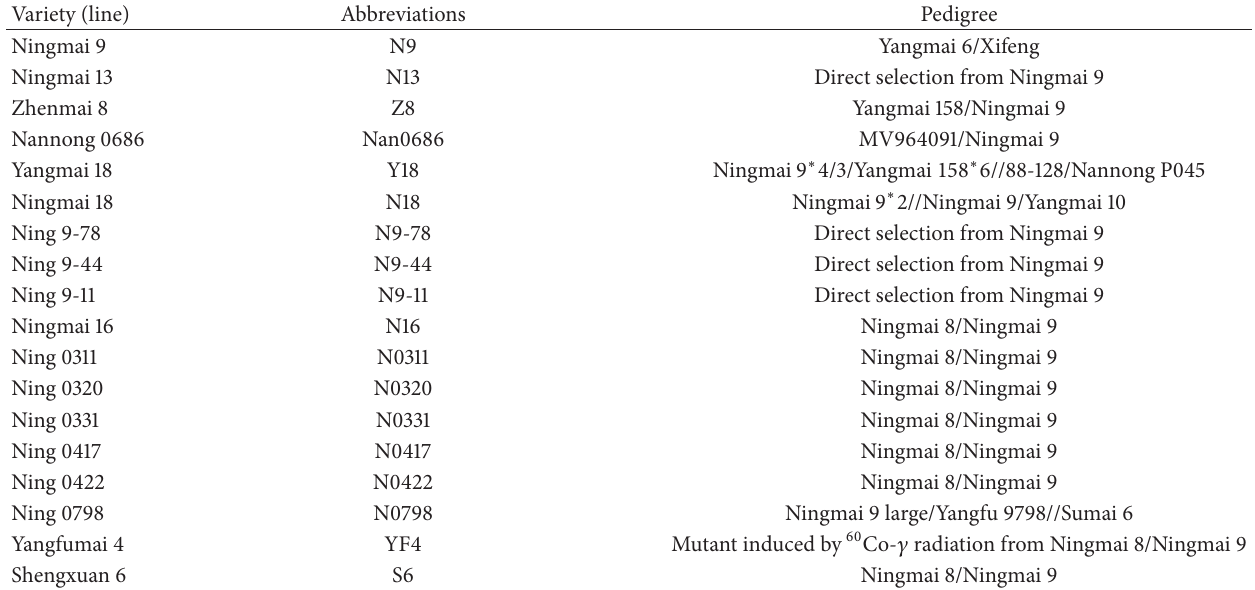
Table 1: Name and pedigree of selected varieties.